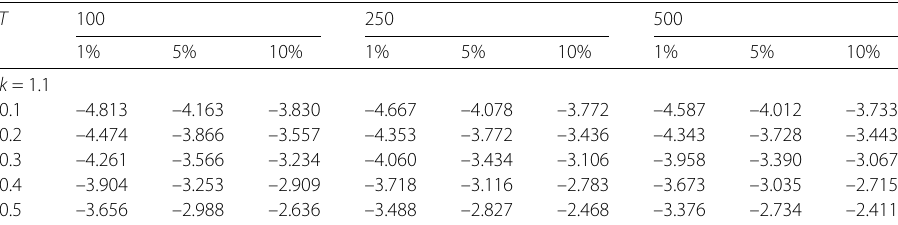
Table B3 Critical values for FI models intercept and trend included in fractional frequency Fourier function d =